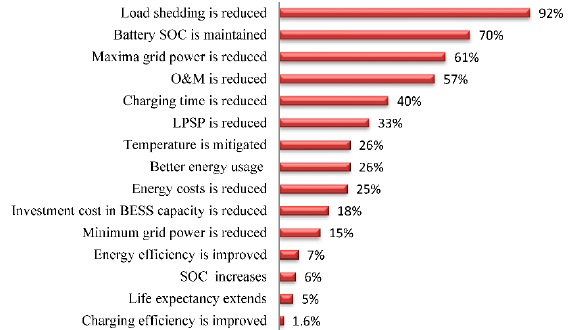
Figure 4. Main advantages of fuzzy logic control (FLC) or model predictive control (MPC) with respect to traditional control methods. SOC: state of charge; O&M: The operating and maintenance costs of a battery energy storage system (BESS) and LPSP: loss possibility to supply power.